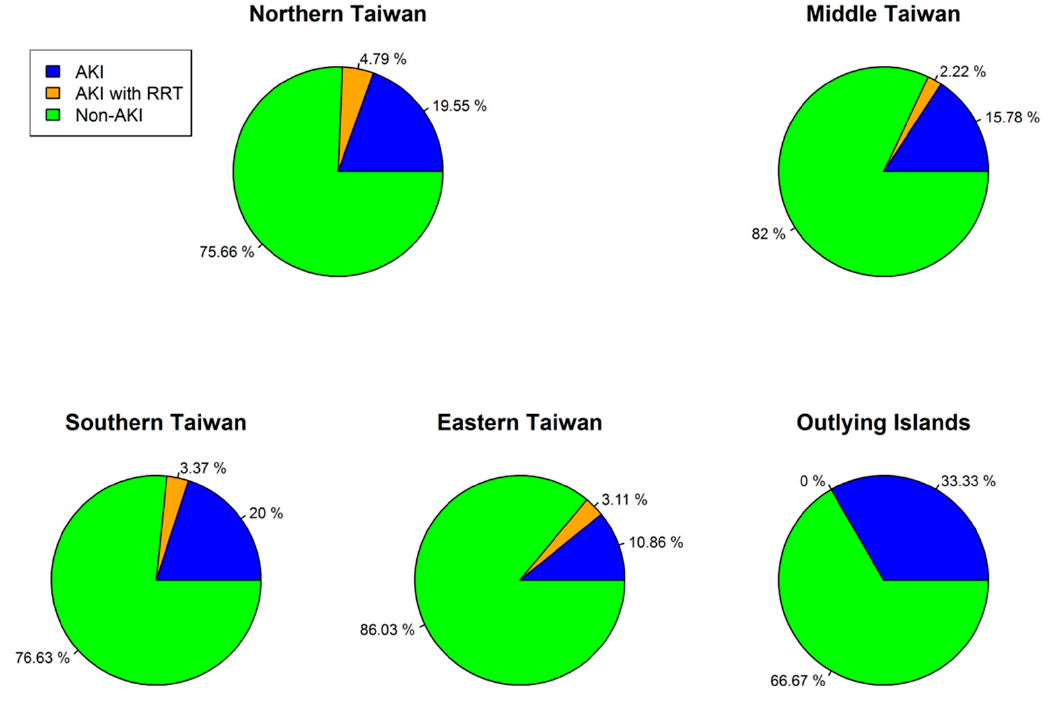
Figure 2. Distribution of Renal Complications by Region in Taiwan.